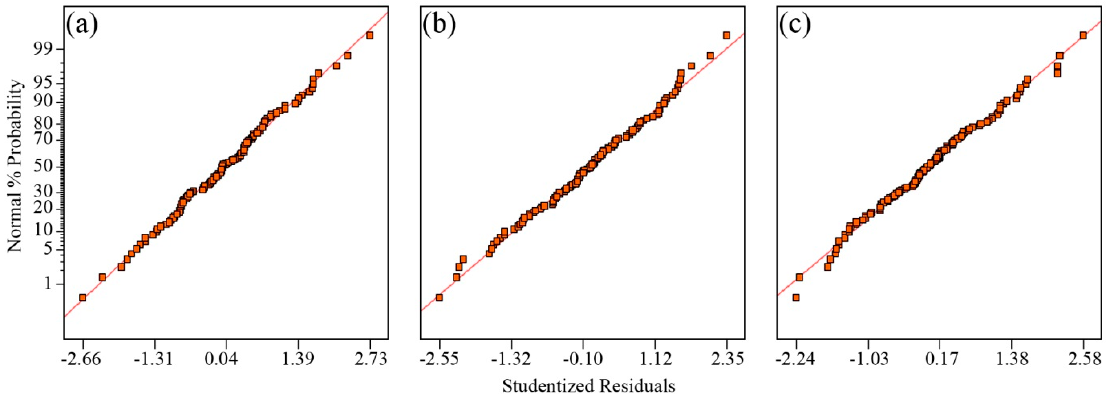
Figure 8. Normal probability plot of residuals for ( a ) σ (×10 − 2 S·cm − 1 ); ( b ) log 10 [ D (×10 − 6 cm 2 ·s − 1 )]; and ( c ) log 10 [ n (×10 18 cm − 3 )].